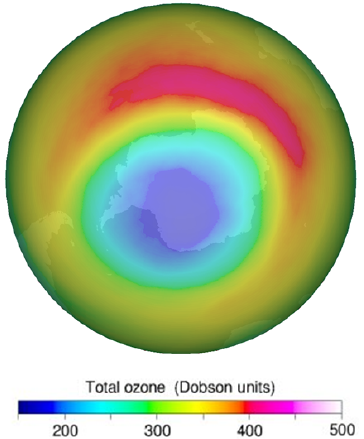
Figure 9. October 2017 monthly average OMI total ozone column over